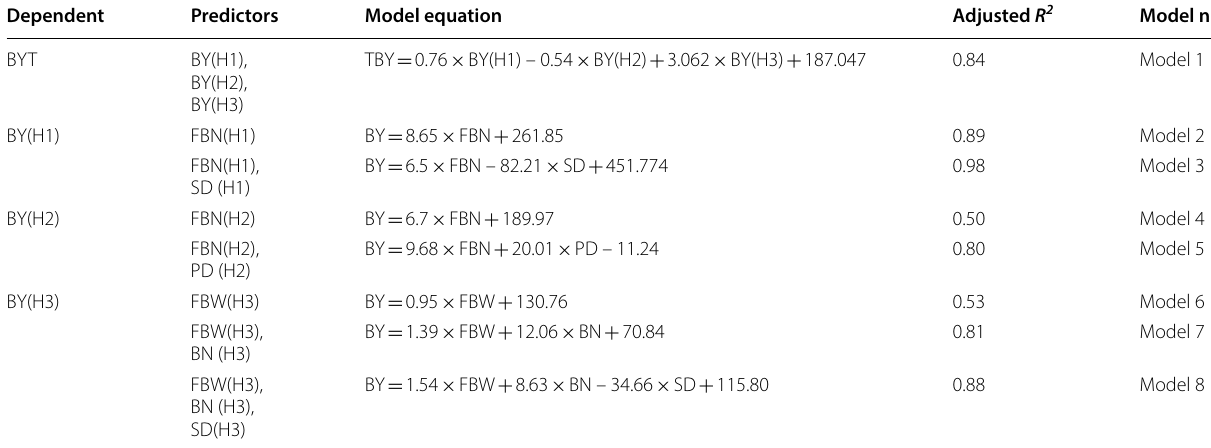
Table 8 Stepwise regression models showing the relation between the biological yield (per harvest/in total) and mushroom